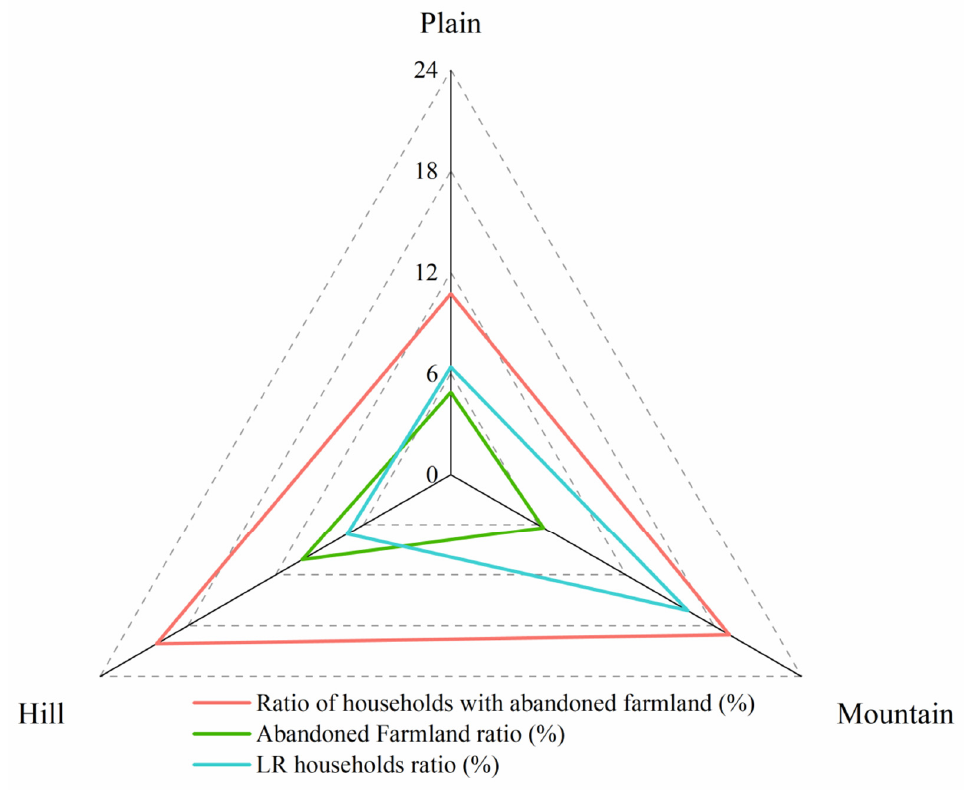
Figure 5. Farmland abandonment and livestock raising (LR) in different